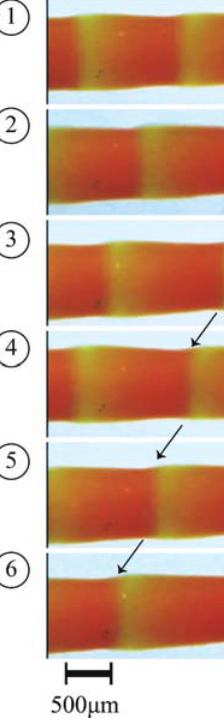
and HNO , 18 °C). The green and 3 3